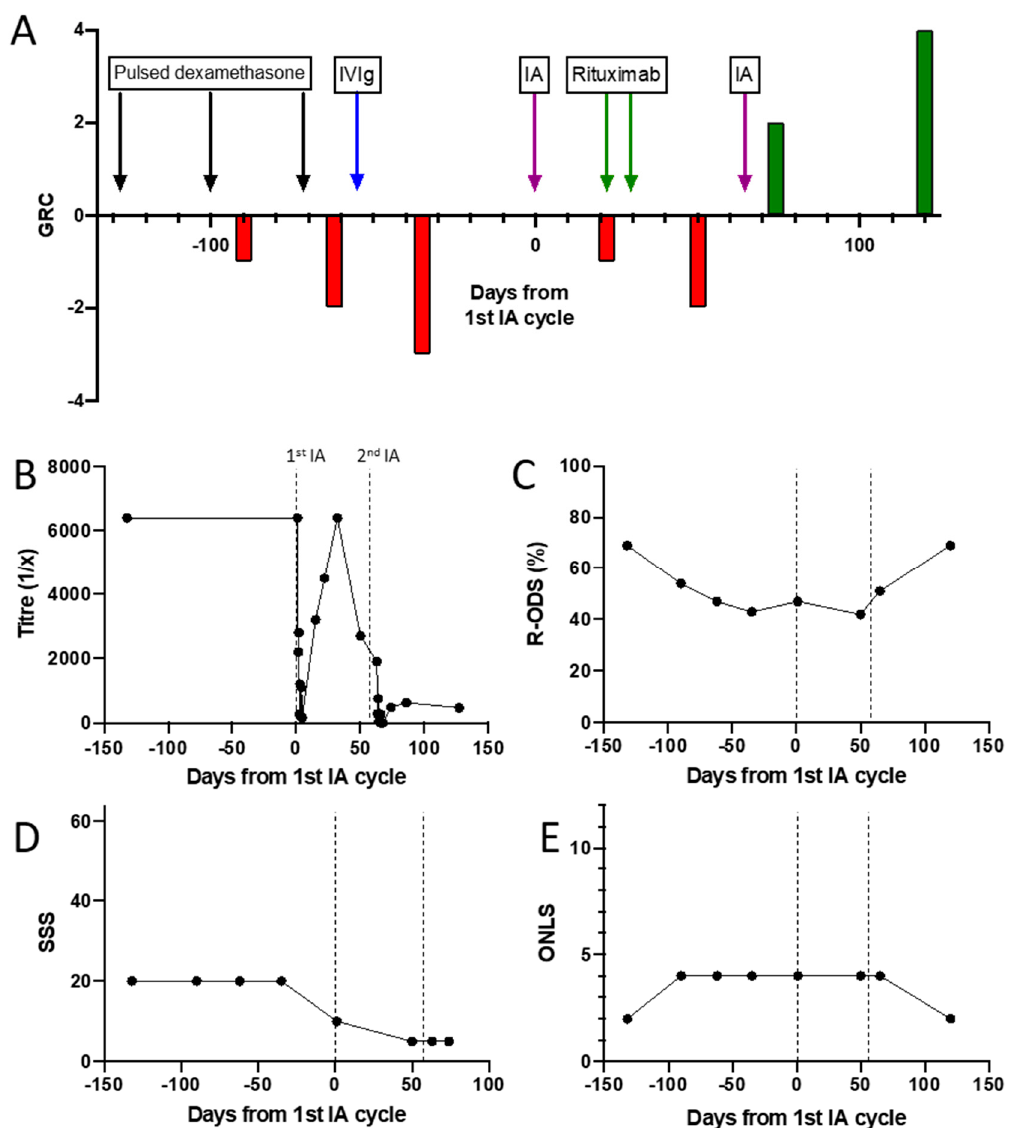
Figure 3. Antibody titres and outcome / disability measures during treatment of a patient with an NF155-antibody-mediated neuropathy. ( A ) Patient global rating of change after treatment with dexamethasone, IVIg, IA and rituximab. ( B ) NF155 antibody titre. ( C ) Inflammatory neuropathy Rasch-built Overall Disability Score. ( D ) Sensory sum score. ( E ) Overall neuropathy limitations score.